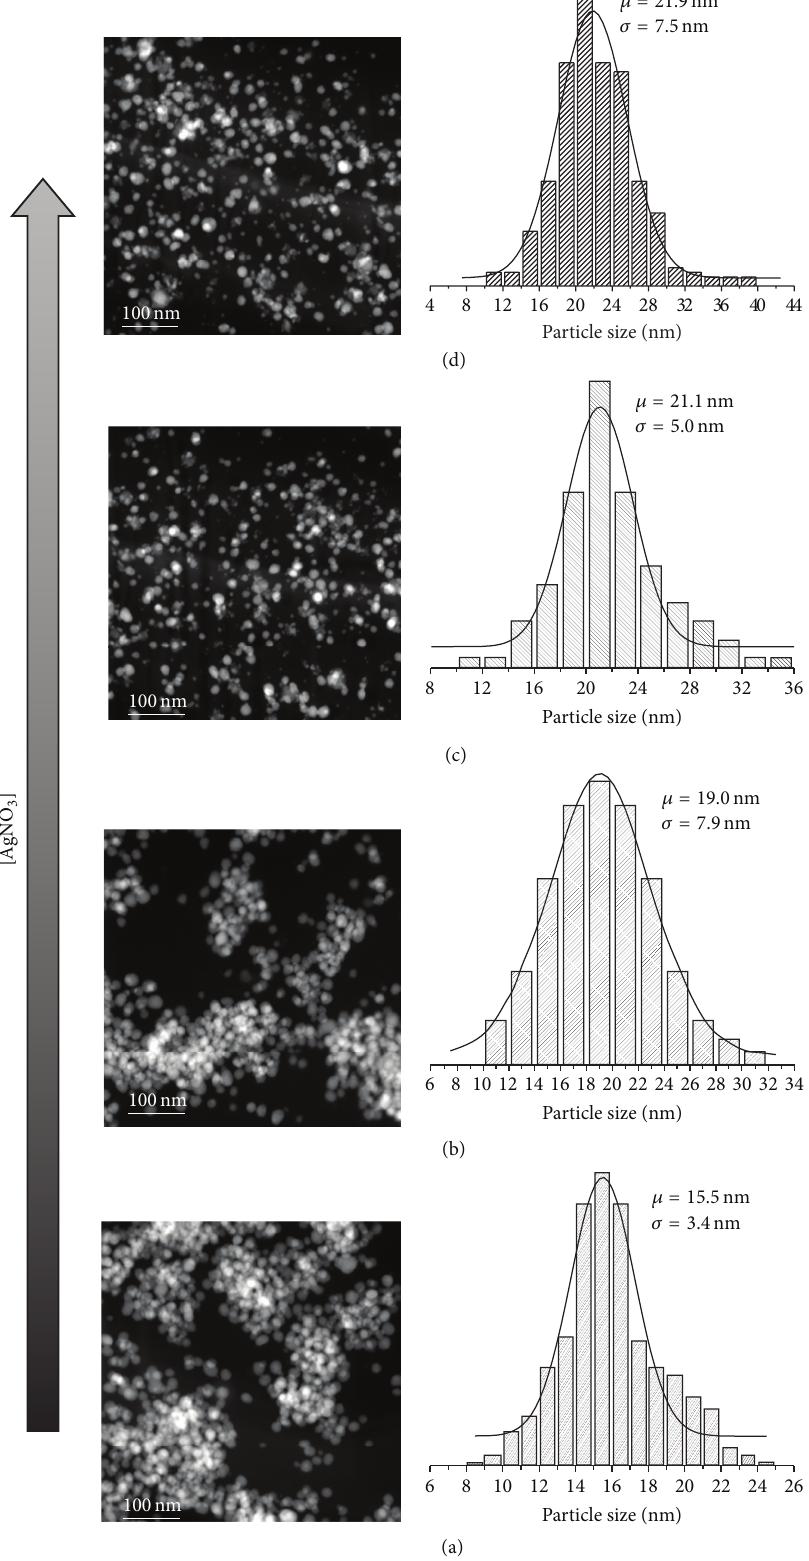
Figure 1: STEM images that show the morphological characteristics of the samples: (a) AgCMC1, (b) AgCMC2, (c) AgCMC3, and (d) AgCMC4, along with their correspondent particle size distribution. The distribution graph of each sample is located on the right hand of its correspondent STEM